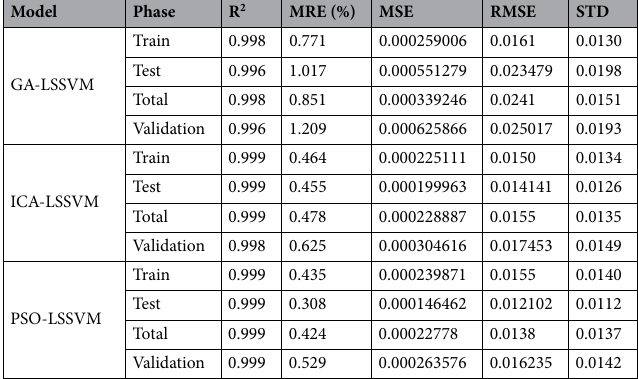
Table 3. Statistical performance evaluation of the